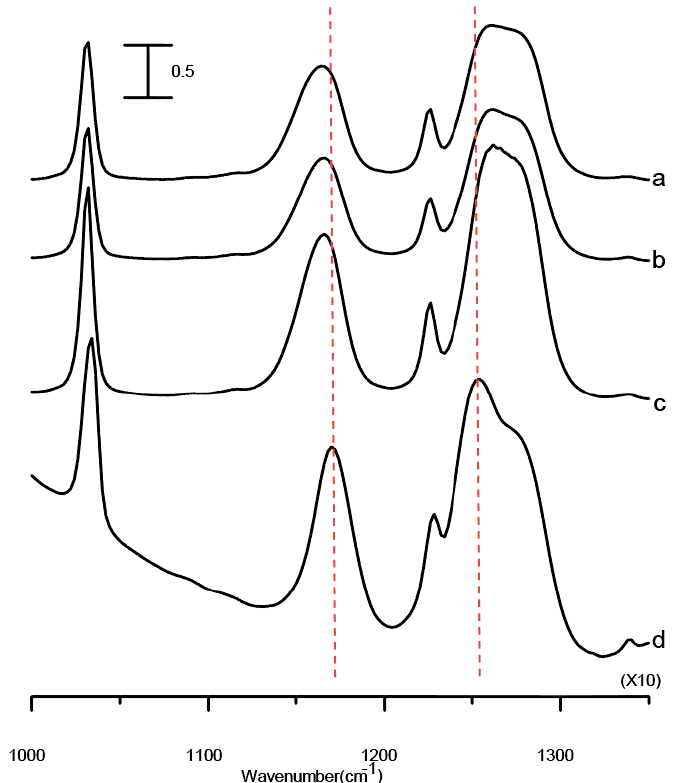
Figure 2. IR spectra of pure [BMIM][TFS] (curve a), the [BMIM][TFS]/Al 2 O 3 mixture (curve b), the mixture after two washes with ethanol (curve c), and the mixture after five washes (curve d), recorded under ambient pressure. Relative intensities of the IR bands are given in increments of 0.05; the scale bar is displayed in the upper left corner of the figure.